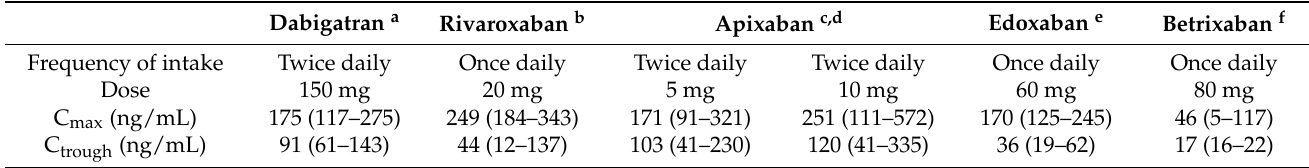
Table 2. DOAC plasma